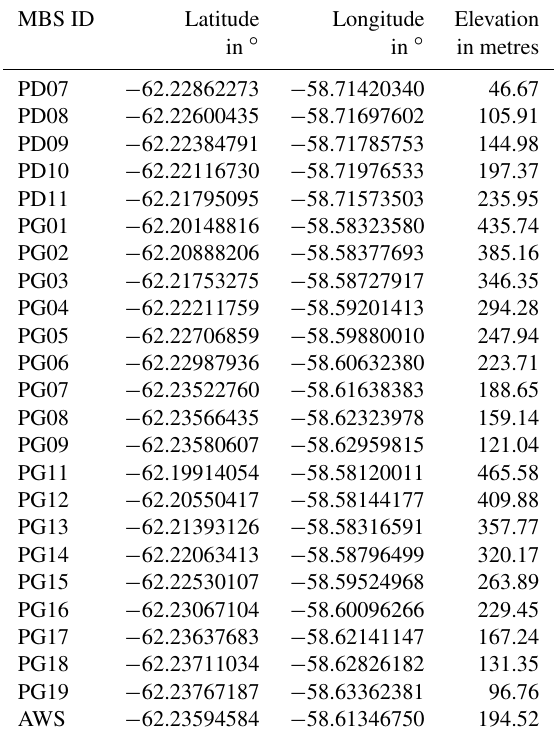
Table 1. Locations of the mass balance stake (MBS) at the AWS and the transects (PG0 x and PG1 x ) on Potter Peninsula and the mass balance stake transect (PD x ) on Barton Peninsula, Fourcade Glacier, on King George Island (see map in Fig. 1), during the time period November 2010 to December 2016.